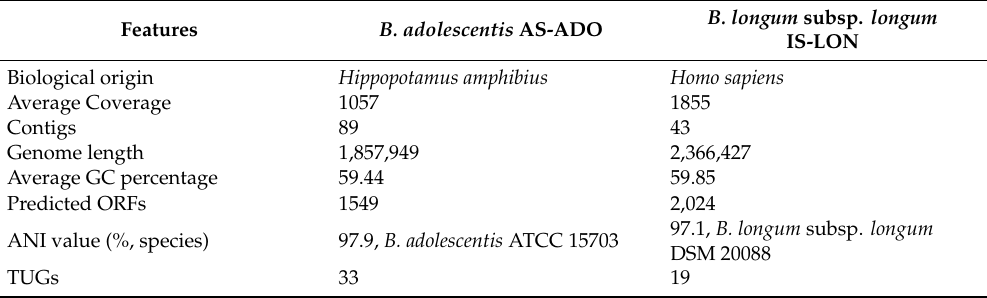
Figure 2. Bifidobacterium adolescentis AS-ADO unique loci. B. adolescentis AS-ADO reconstructed contig sequences are ordered based on the genome of the type strain B. adolescentis ATCC 15703 complete genome and its genes reported as a circular genome atlas (orange circles). Internal circles illustrate B. adolescentis AS-ADO GC% deviation and GC skew (G − C / G + C). Genetic maps exhibit two unique loci of B. adolescentis AS-ADO compared to B. adolescentis strains retrieved from the database. Loci positions in the genome are highlighted with the relative color. Each arrow indicates an open reading frames (ORF), whereas the length of the arrow is proportional to the length of the predicted ORF. Table 1. General features of reconstructed bifidobacterial